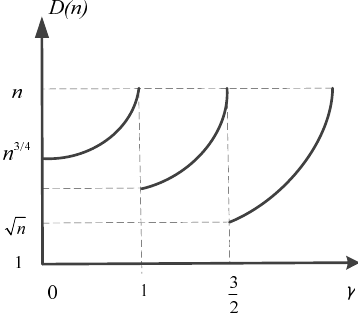
Figure 5. The network delay D ( n ) .